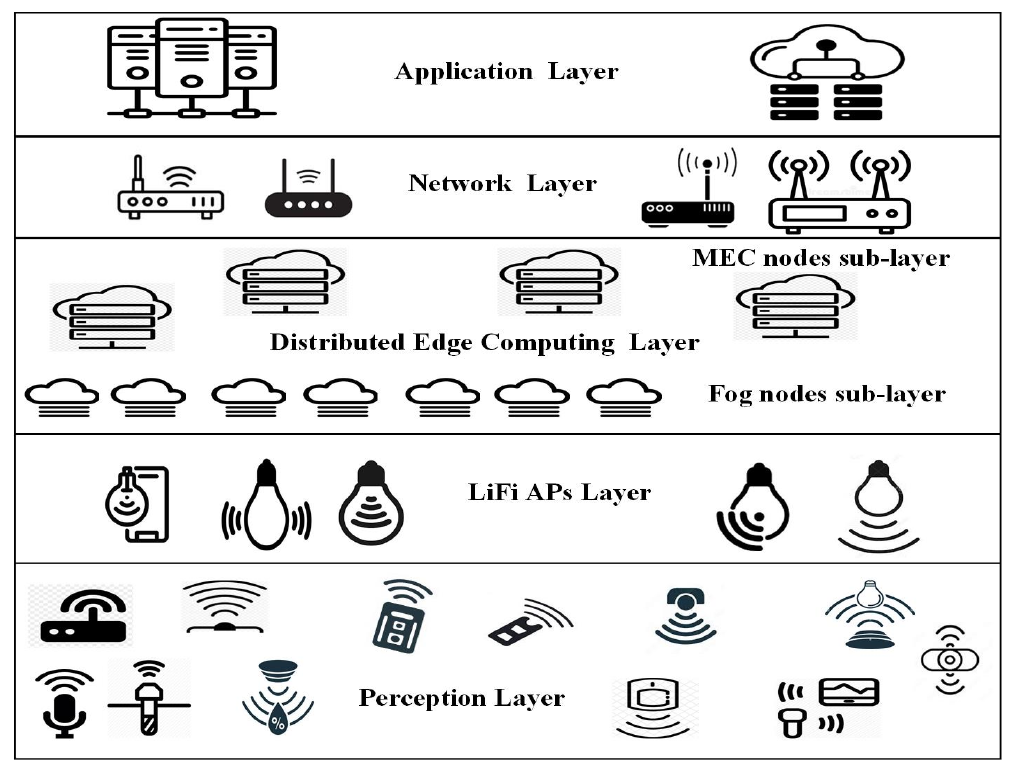
Figure 1. Layering system of the developed LiFi-based IoT system.